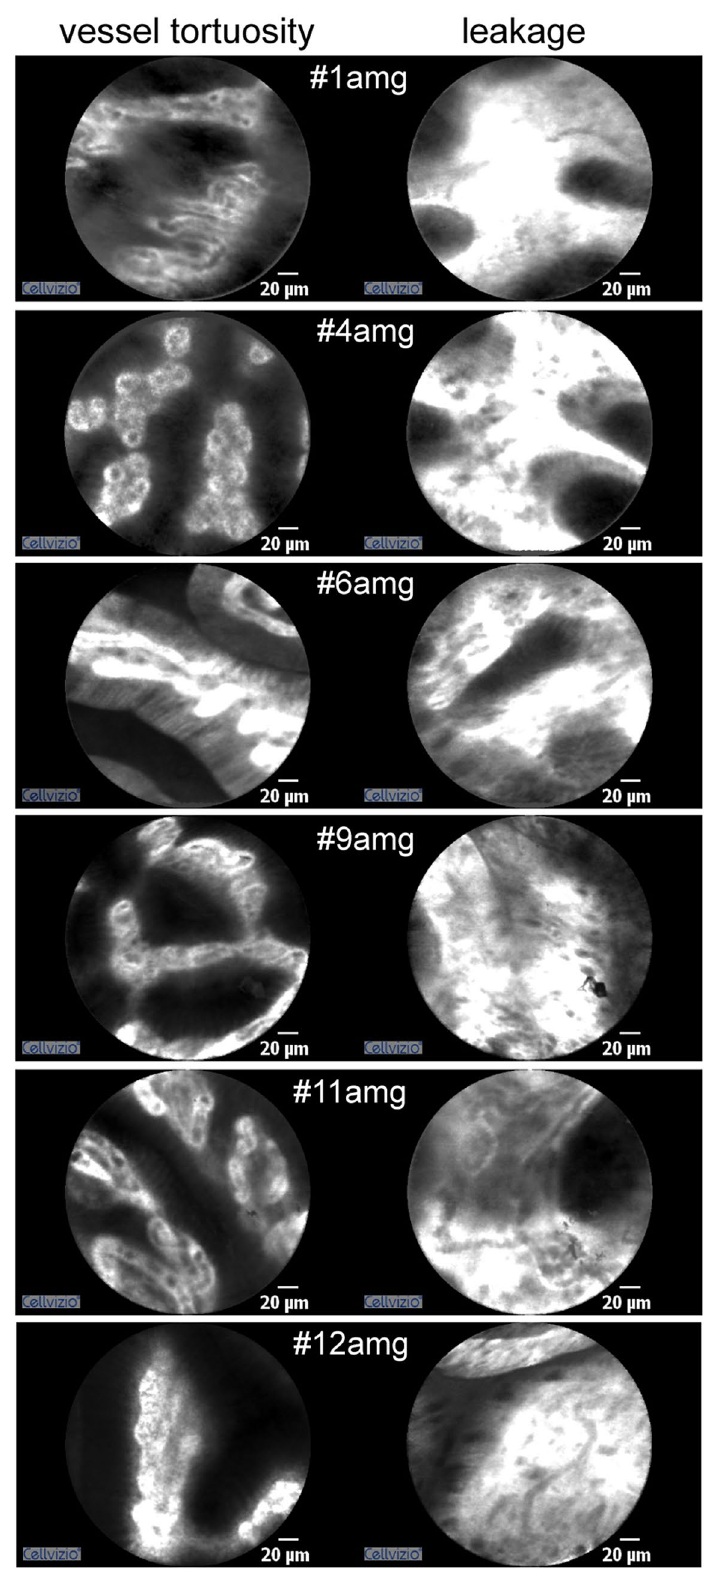
Figure 4. Vascular alterations detected by pCLE in patients affected by atrophic metaplastic autoimmune gastritis (amg). One image for each patient is representative of the presence of the typical tortuous coil-shaped vessels and the other of capillaries with elevated